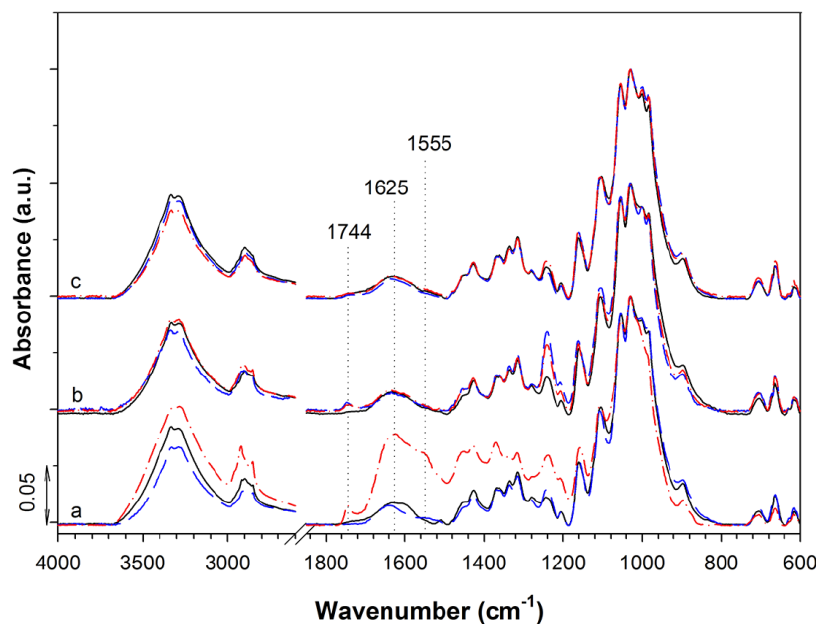
Figure 12. IR ATR spectra of: ( a ) CP; ( b ) CCP-CHT2-Cu10-AA; and ( c ) CCP-CHT2-Cu10-GA samples before (black full line) and after 9 (blue dash line) and 18 (red dash-dot line) days of soil burial.